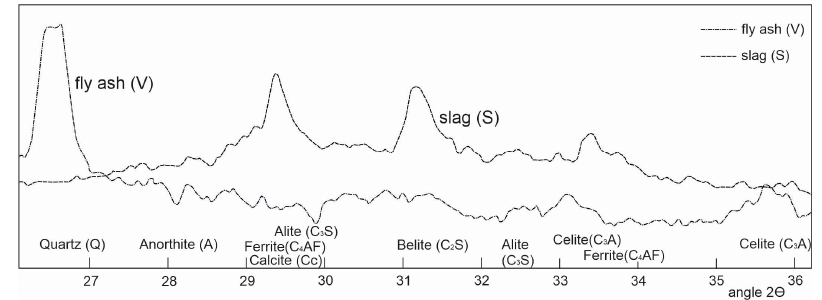
Figure 1. XRD diagrams displaying angle 2 Θ -intensities of cementitious constituents fly ash (V) and furnace slag (S), whereby: Alite—3CaO × SiO 2 ; Belite—2CaO × SiO 2 ; Celite—2CaO × Al 2 O 3 ; Ferrite—4CaO × Al 2 O 3 × Fe 2 O 3 .